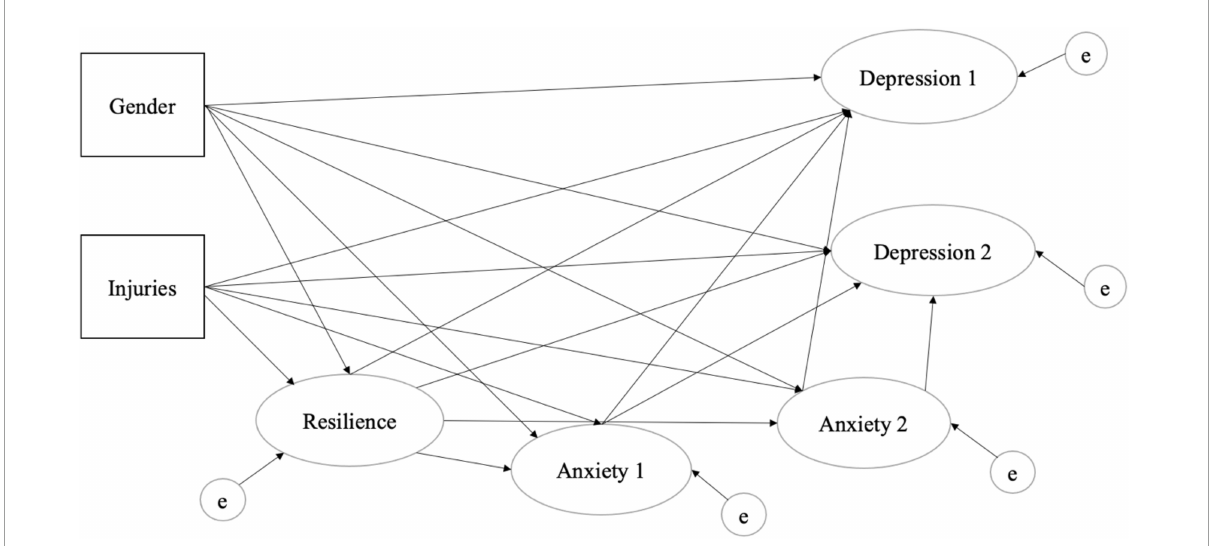
FIGURE1 Proposed structural model between resilience, anxiety, and depression. Note: Injuries include recently reported injured male and female